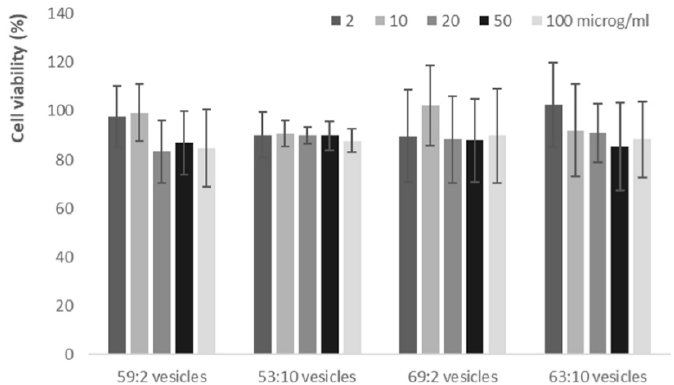
Figure 5. Cell viability of keratinocytes incubated for 48 h with the clotrimazole-loaded, three-dimensionally-structured hybrid vesicles. Data are reported as mean values ± standard deviation of the cell viability expressed as the percentage of the negative control (100% of viability).